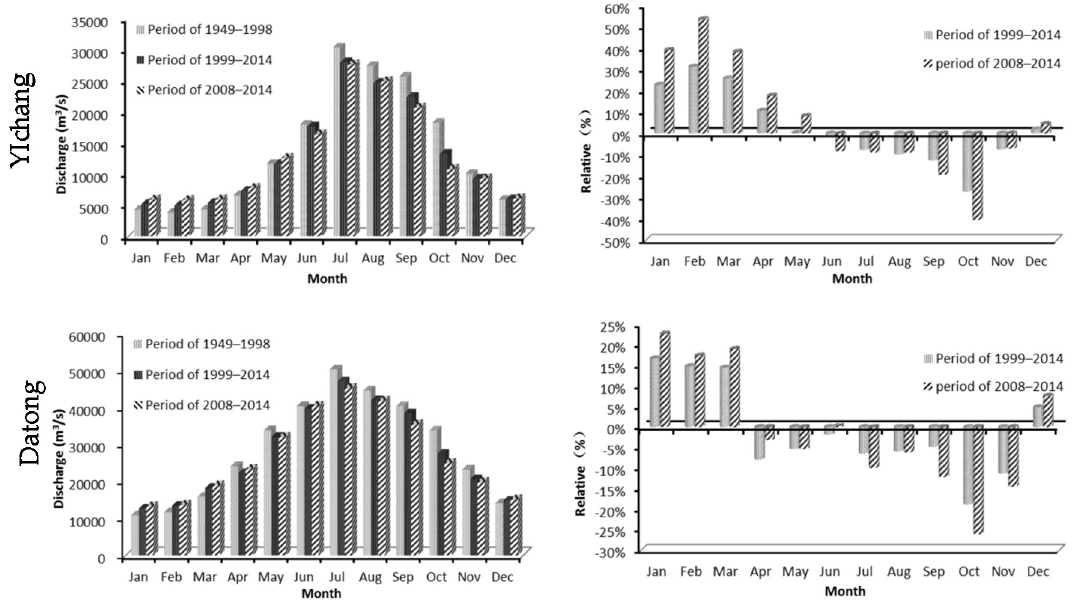
Figure 7. Comparison and anomaly of monthly mean flow between natural and observed series for different